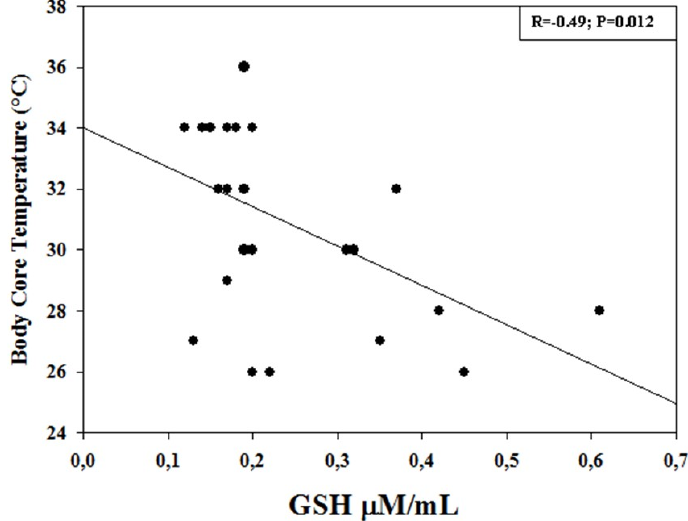
Figure 3. Correlation between GSH concentrations (μM/mL) measured at the end of cardiopulmonary bypass (CPB) procedure and body core temperature (°C) during CPB. There was a significant negative correlation (R = −0.49; p = 0.012).